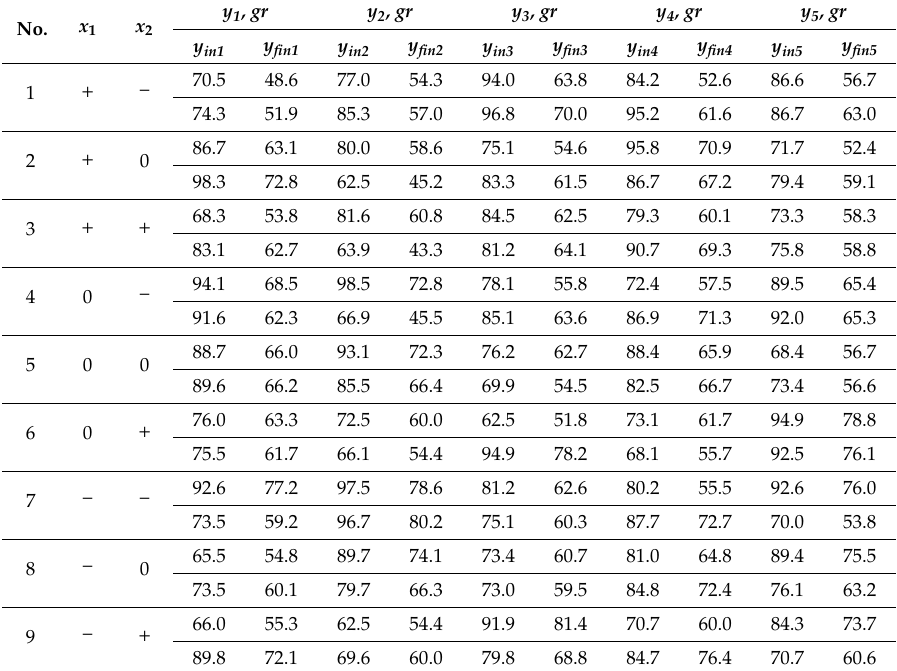
Table 6. Experimental data on the moisture extraction from a wet leather semi-finished